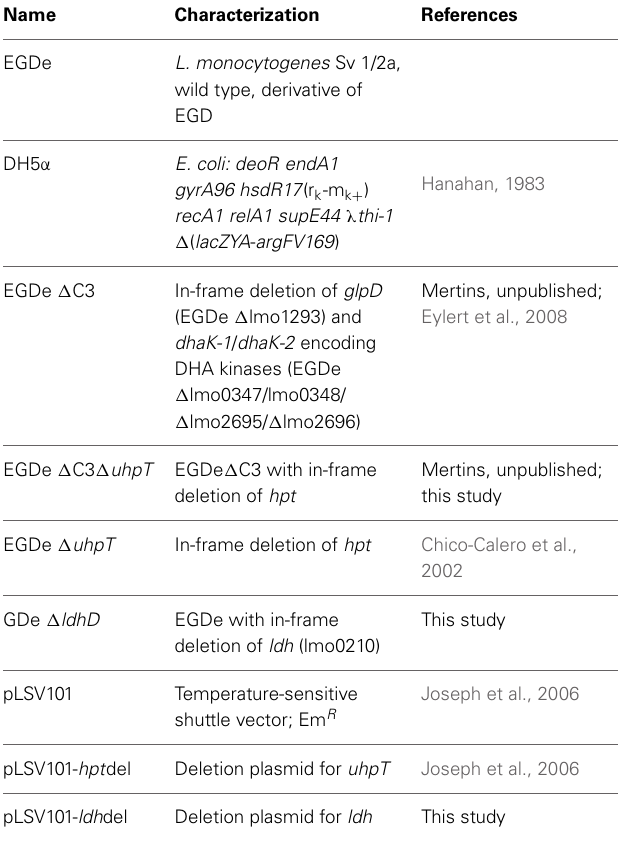
Table 1 | Strains and plasmids used in this